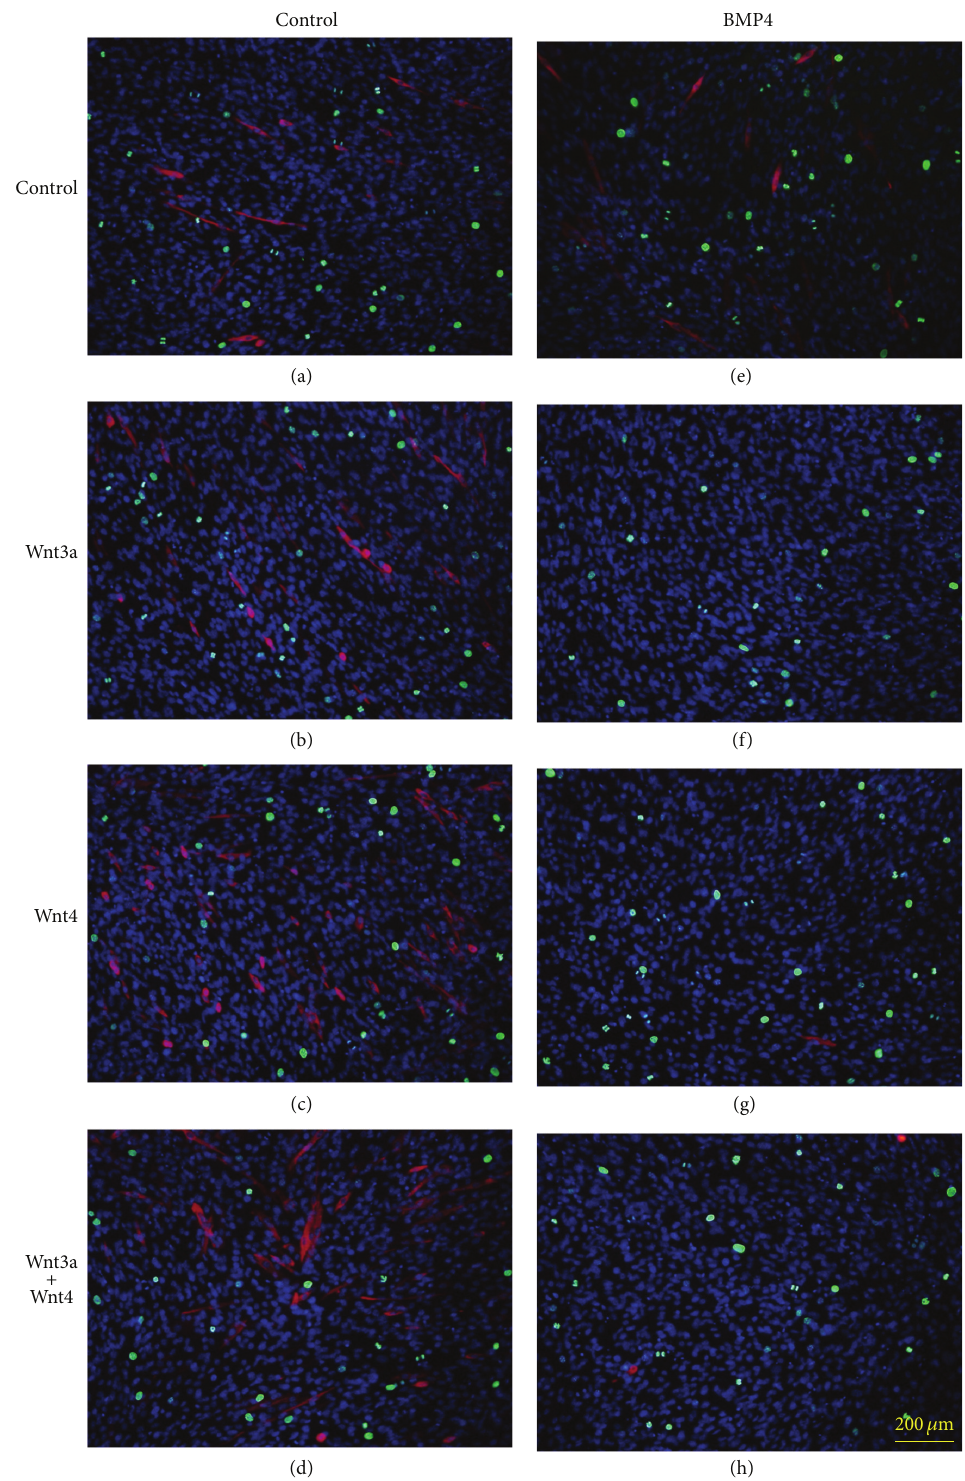
Figure 5: Effect of BMP4 on troponin T expression with or without Wnt3a and Wnt4. (a–h) The recombinant proteins were added as shown in Figure 3 with final concentrations of 125ng/mL Wnt3a, 250 ng/mL Wnt4, and 5ng/mL BMP4, alone or in combination as shown in the figure. Immunostaining and cell counting were carried out as described in Figure 3. Addition of BMP4 entirely abolished troponin T expression in the presence or absence of Wnt3a and/or Wnt4. (a) Control; (b) Wnt3a; (c) Wnt4; (d) Wnt3a + Wnt4; (e) BMP4; (f) Wnt3a + BMP4; (g) Wnt4 + BMP4; (h) Wnt3a + Wnt4 +